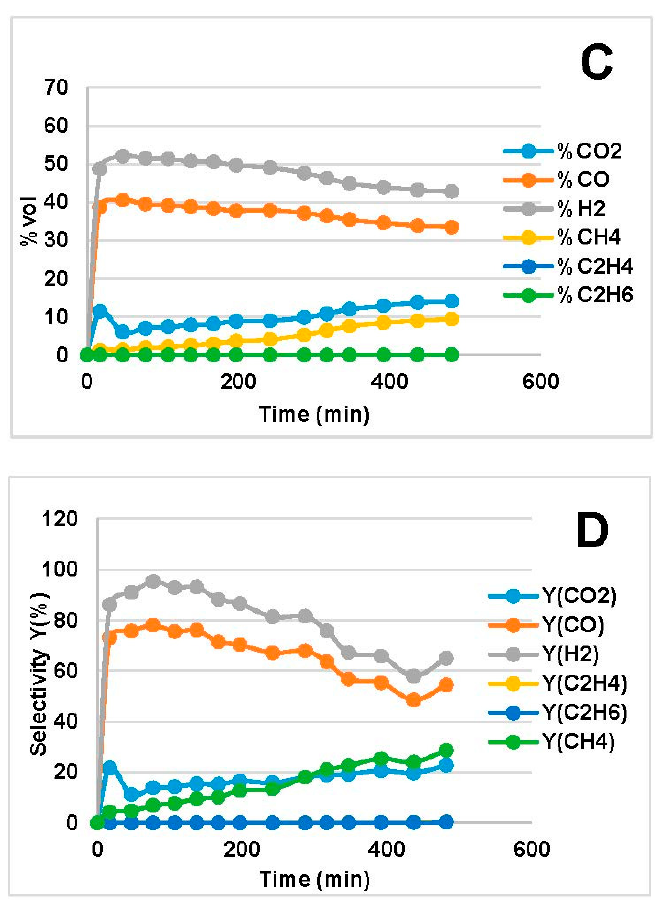
Figure 4. Concentration and selectivity profiles of bio-oil MemU SR at 800 °C: ( A , B ) WHSV = 1.7 g/g cat /h; and ( C , D ) WHSV = 6.6 g/g cat /h.